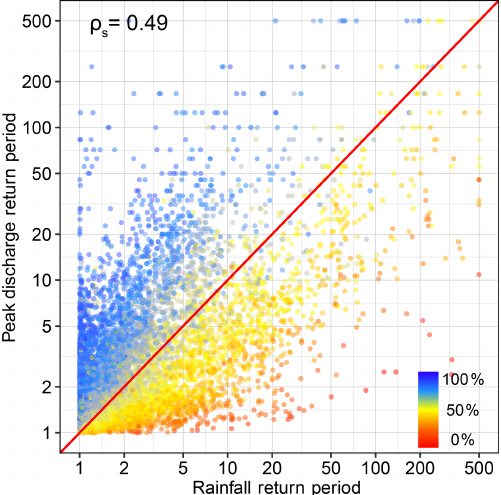
Figure 9. Relationships between rainfall and simulated peak dis- charge return periods estimated via our process-based method us- ing Stage IV rainfall data. Spearman rank correlation ρ s is given. Color indicates the normalized modeled antecedent soil moisture · value calculated as soil moisutre − min . soil moisture field capacity − min . soil moisture